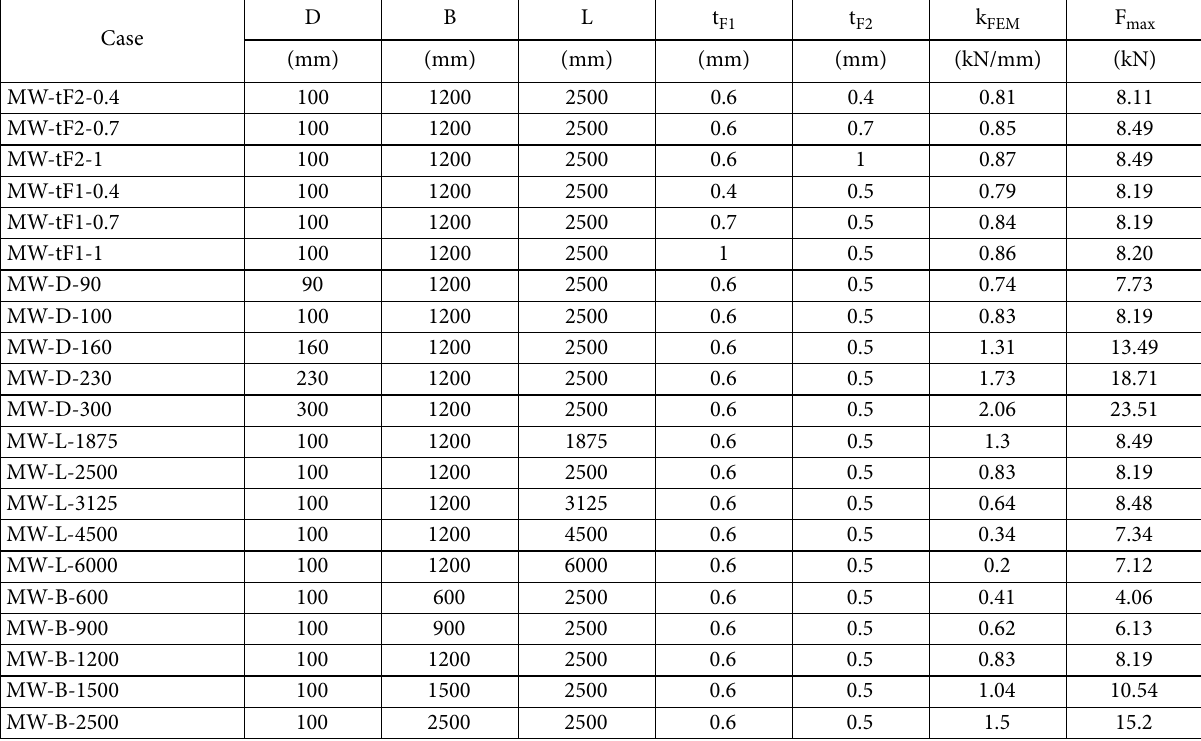
Table 1. Bending stiffness of MW sandwich panels at room